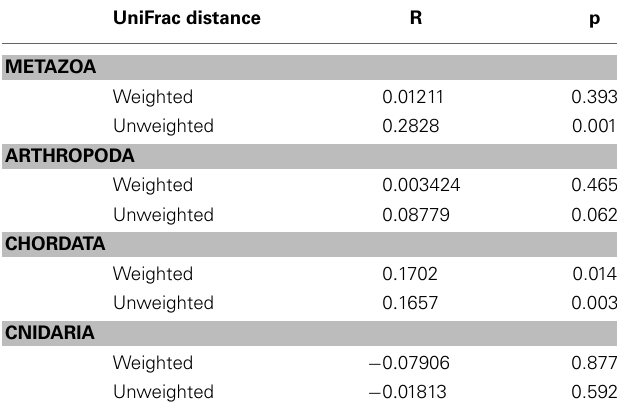
Table 6 | R and p -values for ANOSIM results (permutations = 999) for weighted and unweighted Unifrac distance matrices at various taxonomic